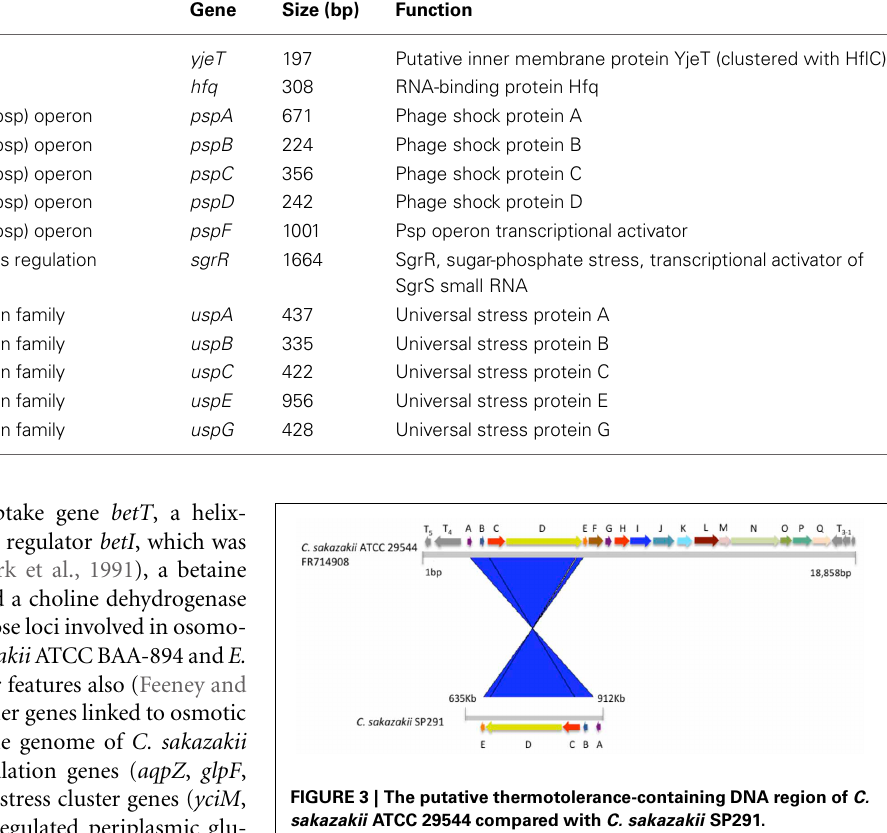
containing this presumptive marker of thermotolerance was com- pared to similar regions in other bacteria (Gajdosova et al.,